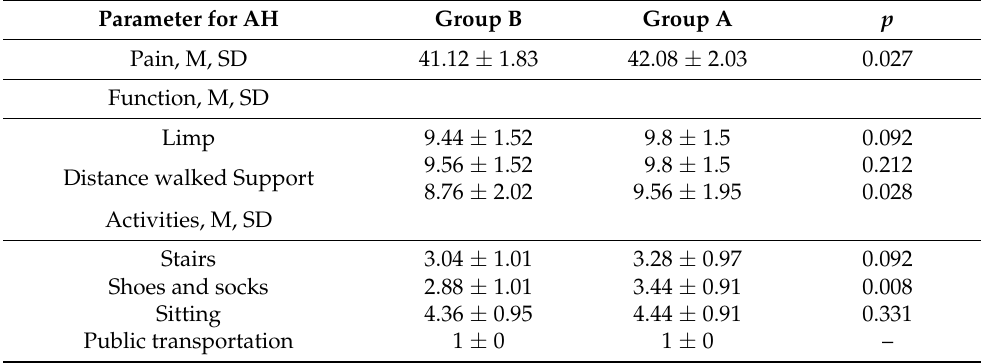
Table 5. The values of the mHHS parameters at the AH level, at the end of the study. Parameter for AH Group B